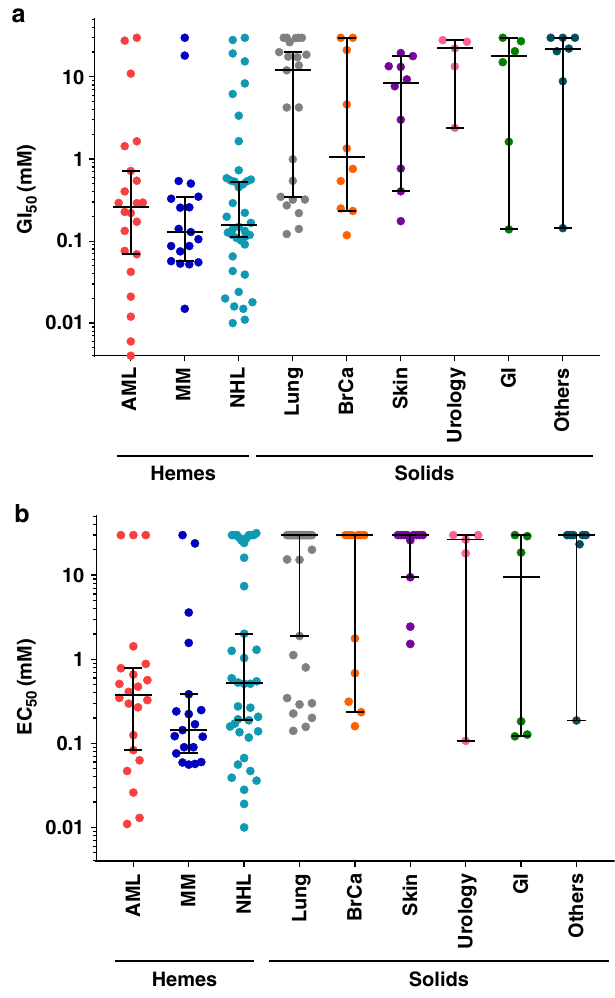
Fig. 5 Hematological cell lines are preferentially sensitive to AZD5991. a Viability ( n = 142) and b caspase-3/7 induction ( n = 154) evaluated in cancer-derived cell lines treated with AZD5991 for 24 or 6 h, respectively. Data are shown as median with 95% con fi dence